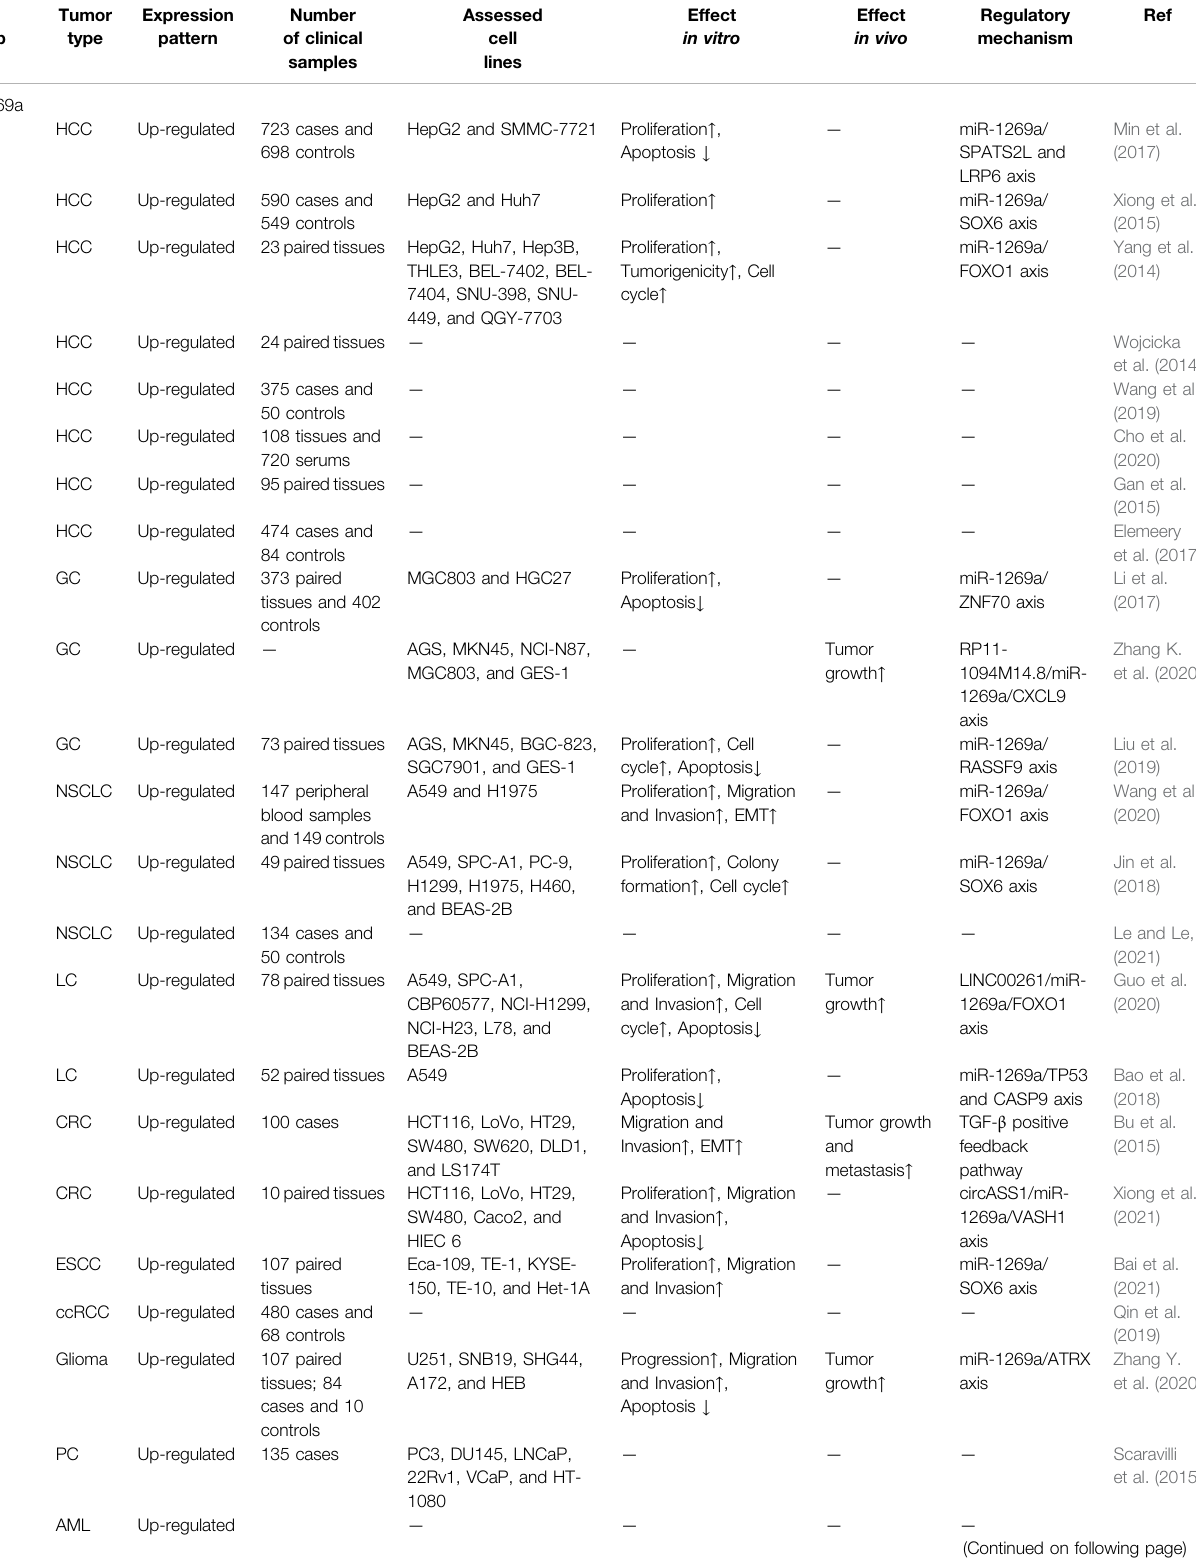
TABLE 1 | The role of miR-1269a and miR-1269b in different human cancers. miR- Tumor 1269a/b type